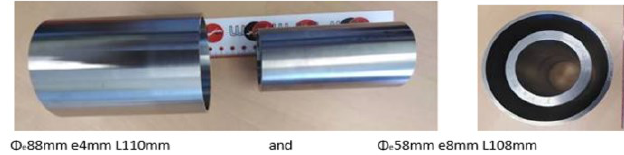
Fig. 17. Representative mock-ups with Electron Beam weld